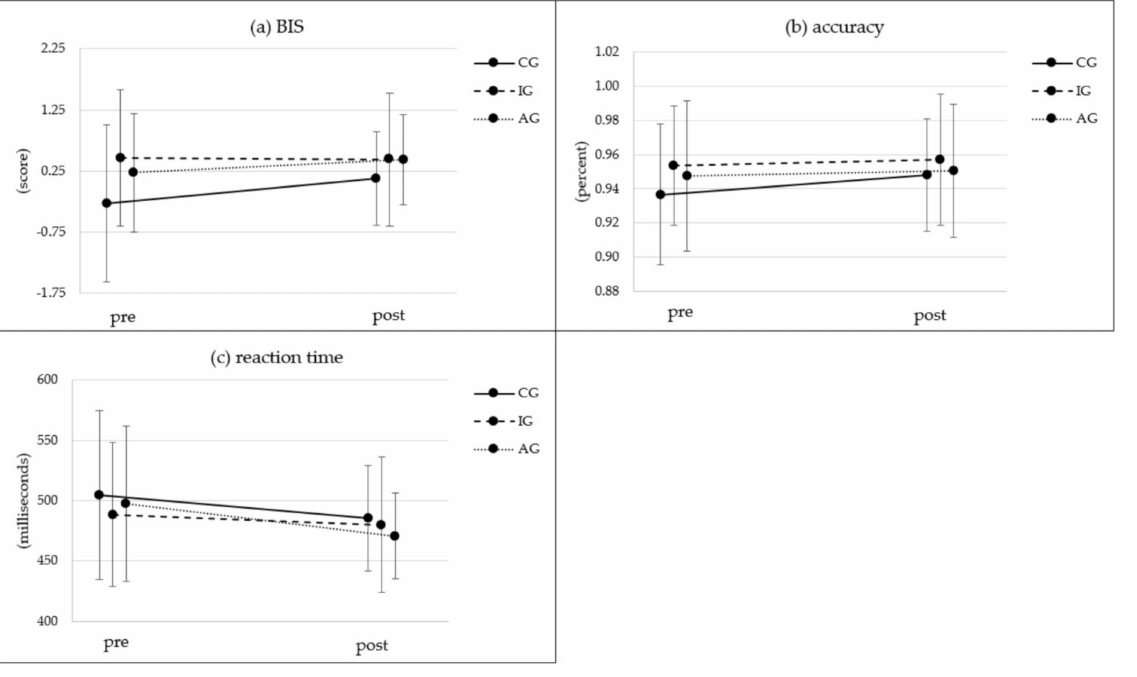
Figure 5. Balanced integration score for the Simon task: ( a ) BIS, ( b ) accuracy (%) and ( c ) reaction time (ms) in pre- and post-test conditions. BIS = balanced integration score; CG = control group; IG = intervention group without activity tracker; AG = activity tracker group receiving the same web-based intervention as the